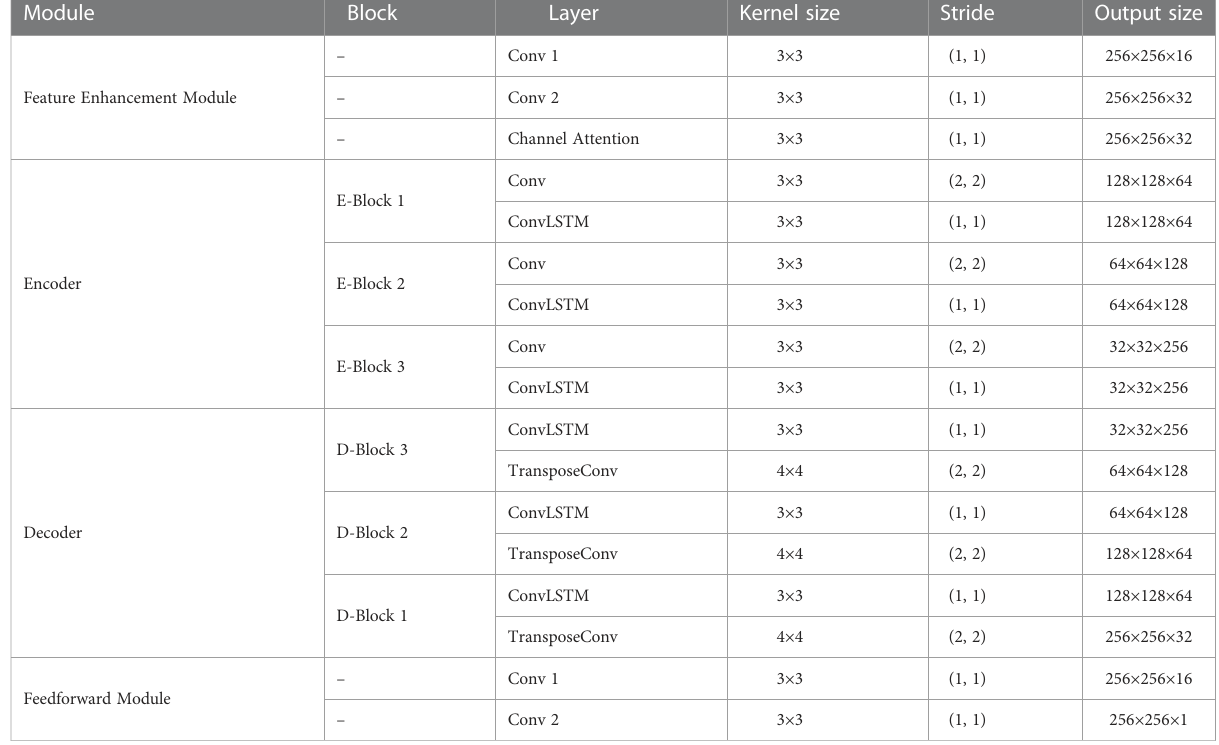
TABLE 1 Architecture of